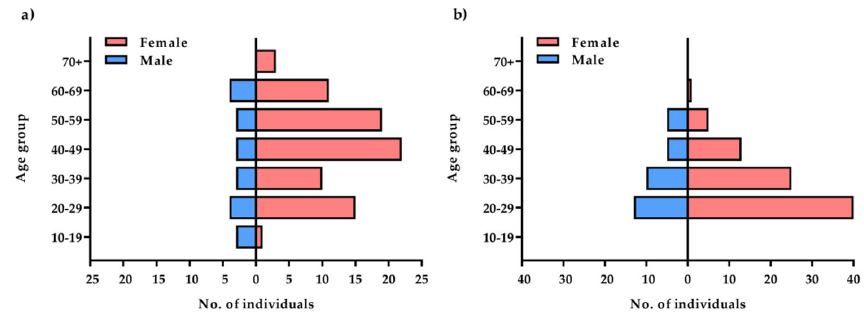
Int. J. Mol. Sci. 2022 , 23 , x FOR PEER REVIEW 3 of 12 failure and impaired neural tube closure [34,35]. Single ‐ nucleotide polymorphisms (SNPs) of AGO genes can lead to global deregulation of the processes in which AGOs are involved. Although the contribution of different SNPs in depression has been extensively studied [36–38], there are hardly any studies on genes in the miRNA biogenesis pathway,